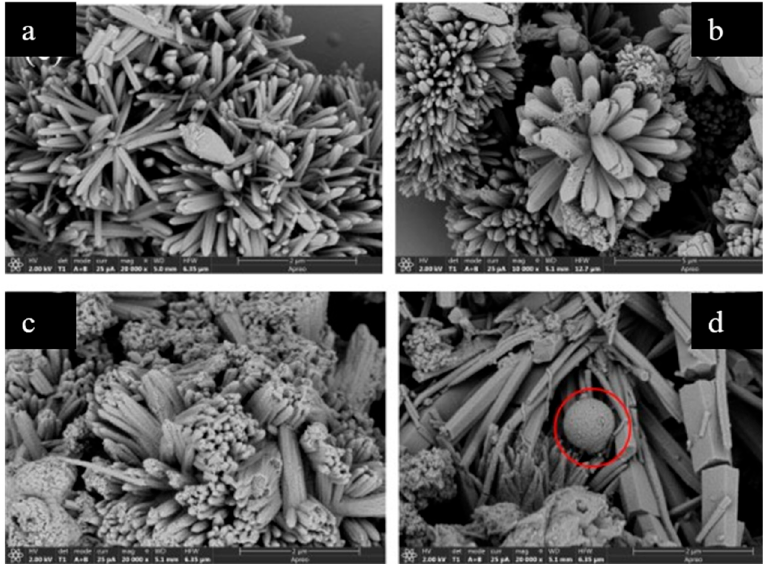
Figure 12. SEM images of ( a ) Fe 1 Co 3 -MOF-74, ( b ) Fe 1 Co 2 -MOF-74, ( c ) Fe 2 Co 1 -MOF-74, and ( d ) Fe 3 Co 1 -MOF-74 . Adapted with permission from Ref. [81], 2023, Elsevier.